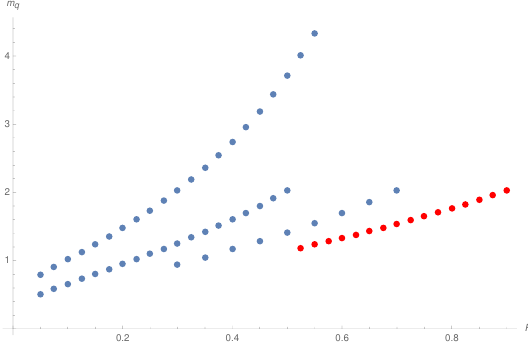
Figure 11 . The relation between produced quark mass m q and radius R 1 at which the pair is produced for various loops in the region (i). The plots are made for m Q = 9 : 5 and for di(cid:11)erent outer radii R 2 = f 1 : 6 ; 1 : 98 ; 2 : 37 ; 2 : 78 g . The largest value of R 2 corresponds to the bottom (red)